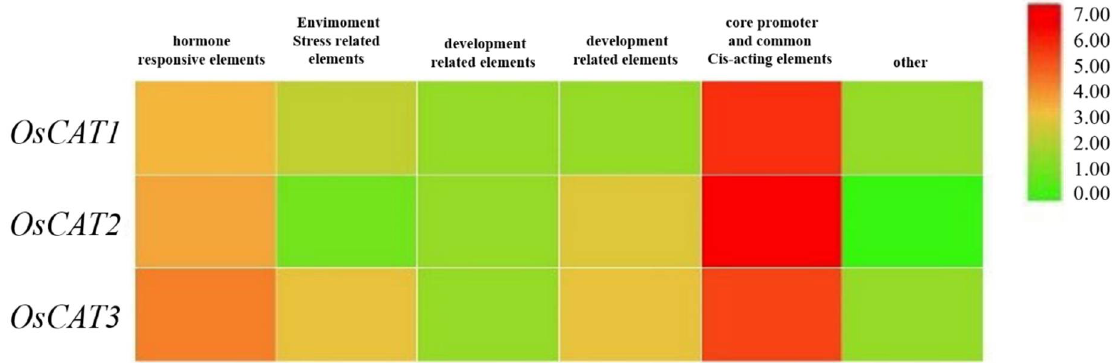
Figure 3. Heat map analysis of upstream elements in the OsCAT gene family. In the heat map, the red color shows high enrichment, and the green color shows low enrichment levels.